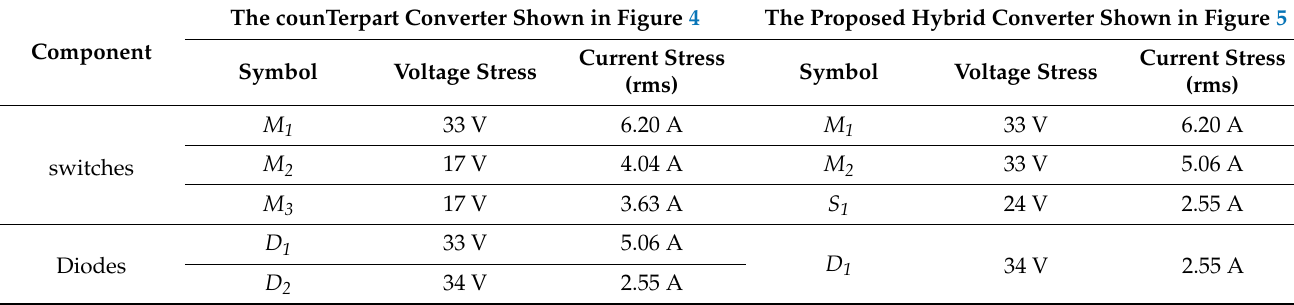
Table 5. Current and voltage stresses of components between the proposed hybrid converter and the counterpart